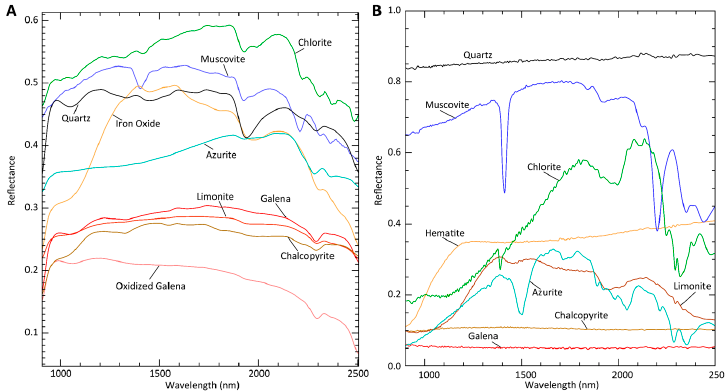
Figure 10. Endmember spectral plots from each class that was mapped in Figure 11, ( A ) derived from hyperspectral data and ( B ) from the USGS spectral library [36].